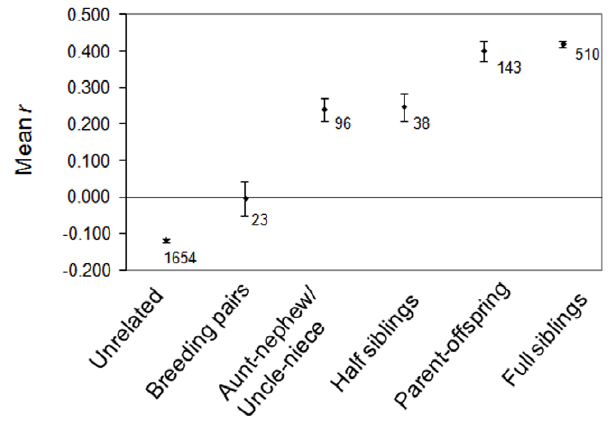
Figure 1. Relatedness comparisons with kinship levels. Mean pairwise relatedness ( r ) for different relationships in the KZN wild dog population with numbers of dyads examined for each category indicated.